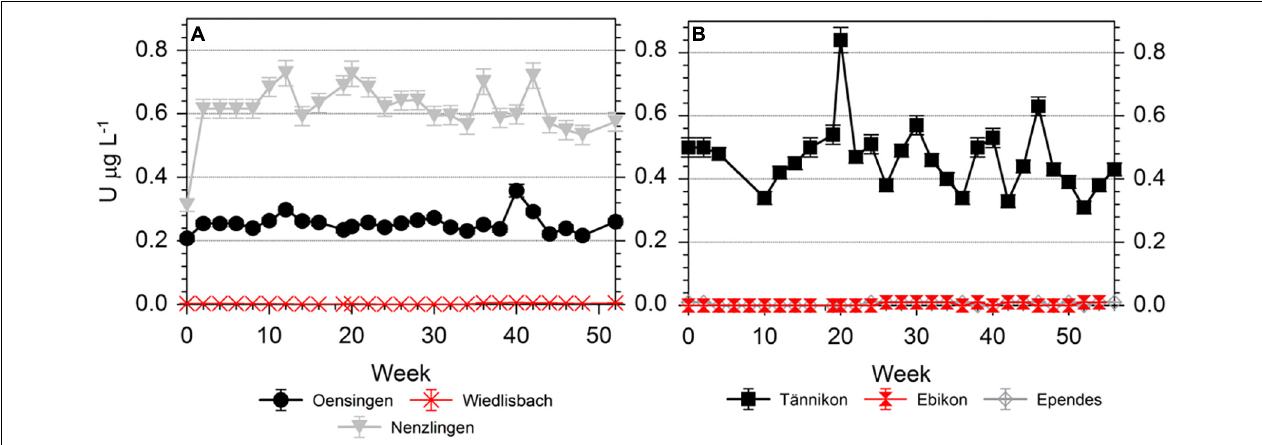
FIGURE 4 | Temporal variation of the U concentrations in the soil solutions of (A) arable sites and (B) grassland sites, during the sampling time of 52 weeks (arable sites) and 56 weeks (grassland sites). TABLE 1 | Speciation of U and charge of U species in soil solution at the different study sites modeled with Visual MINTEQ. Carbonato-U Other inorg. U Organo-U U cationic U neutral U anionic complexes a complexes b complexes c species species species %